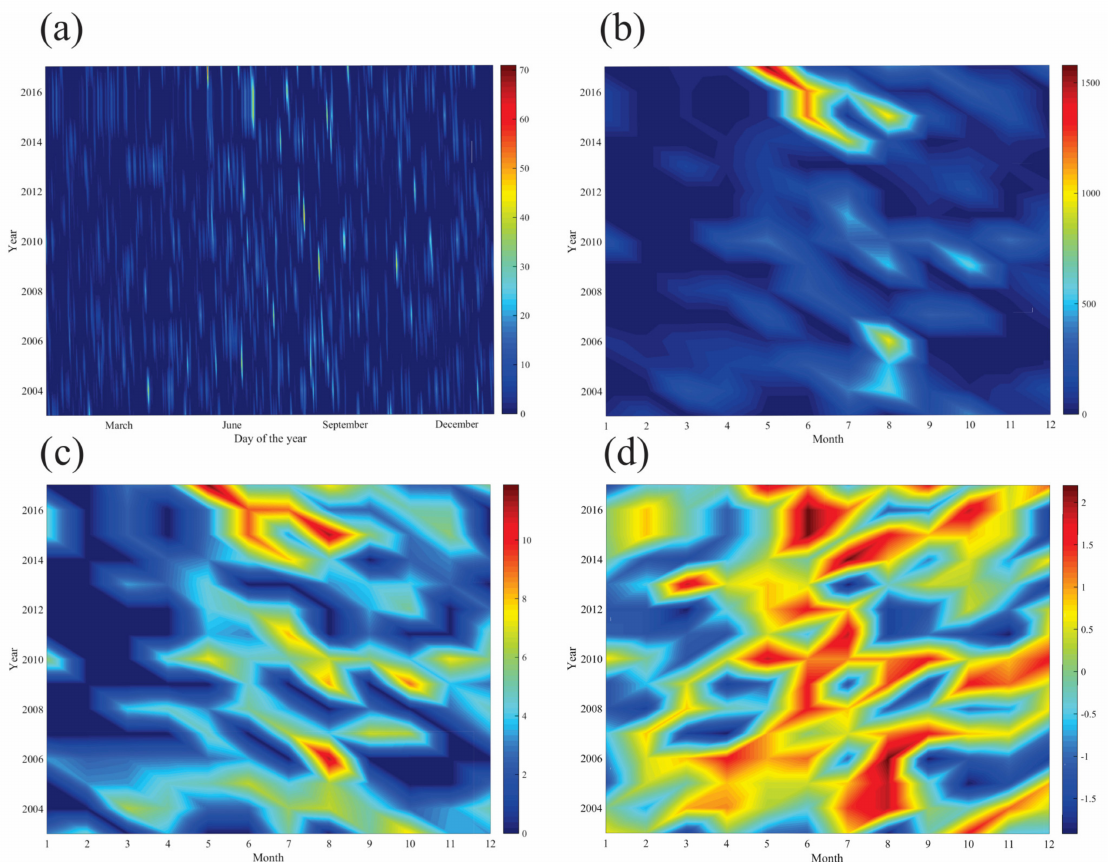
Figure 8. Temporal variability of selected meteorological and erosion parameters: daily precipitation amount in mm ( a ); rainfall erosivity— RE in MJ*mm*ha − 1 h − 1 ( b ); erosion density— ED in MJ *ha − 1 h − 1 ( c ) and standardized precipitation index— SPI ( d ). Data source: calculations based on [80].